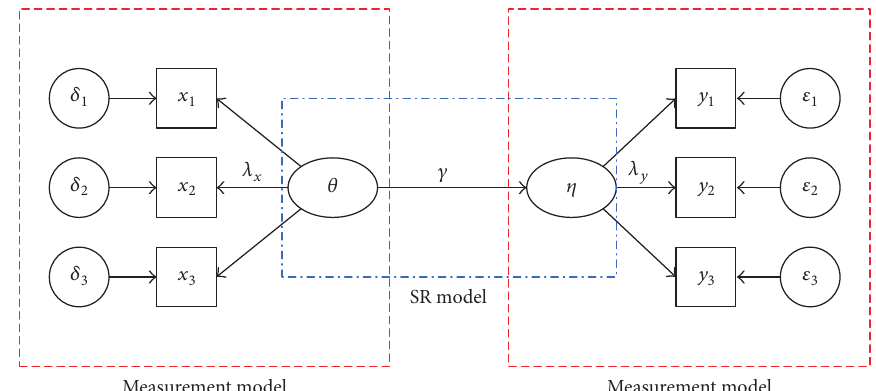
Figure 2: A simple form of SEM model.